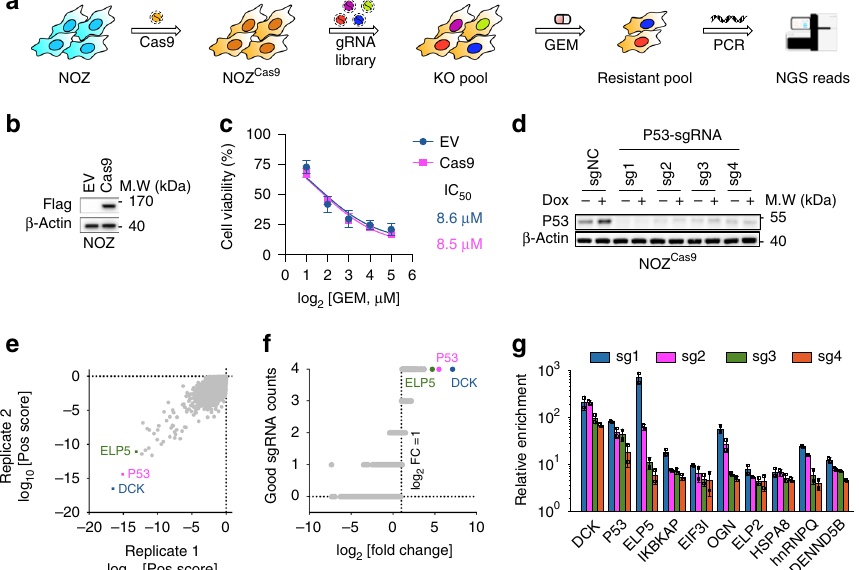
Fig. 1 CRISPR-Cas9 genome editing ef fi ciency and CRISPR screen results in GBC cells. a Schematic drawing of a positive screen for gemcitabine treatment using a two-vector system in NOZ cells. b A NOZ Cas9 cell line was generated that stably expressed Flag-Cas9. c NOZ Cas9 and control cells exhibit similar viability under gemcitabine (GEM) treatment at indicated doses. IC 50 , 50% inhibitory concentration. d P53 protein was signi fi cantly depleted in NOZ Cas9 cells infected with lentiviruses-delivered P53 -targeting sgRNAs, followed by treatment with 1 µ M doxorubicin (Dox) or vehicle for 12 h. sgNC, non-speci fi c control sgRNA. e – g The sgRNA read counts after GEM treatment were normalized to the baseline counts in CRISPR screen and analyzed by MAGeCK software, and the results were presented as positive scores in two replicates ( e ), the number of good sgRNAs in two pooled replicates ( f ), and fold- changes in the top 10 genes exhibiting superiorly enriched sgRNAs ( g ). Data represent the mean ± S.D. in c ( n = 3 independent experiments) and g ( n = 2 independent experiments), error bars represent